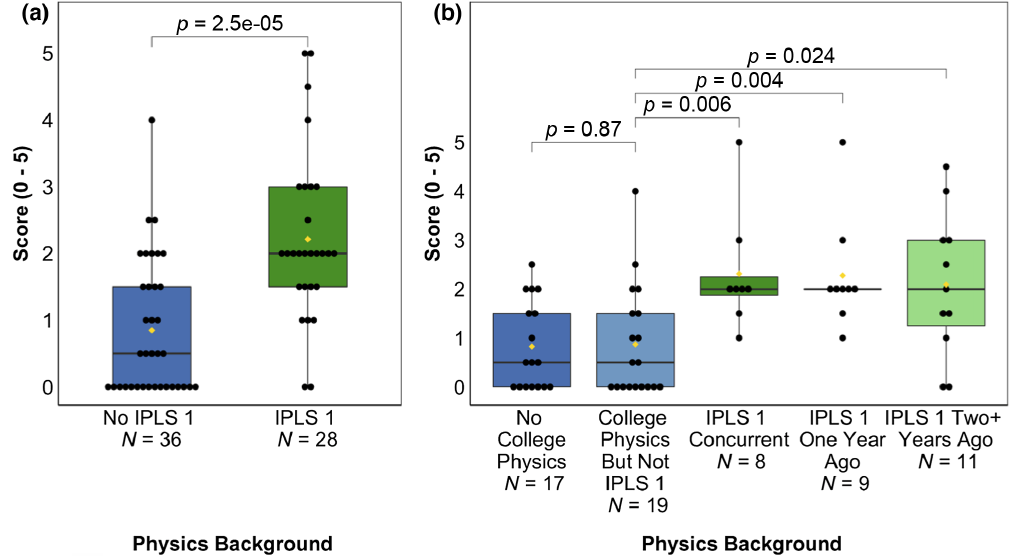
FIG. 2. Scores on the IPLS 1-specific elements of the code. (a) Students who had taken IPLS 1 (green box plot) scored significantly higher on the IPLS 1-specific elements of the code than those who had not taken IPLS (blue box plot). (b) Scores on the IPLS 1-specific elements of the code for those who had taken no college physics, those who had taken non-IPLS 1 college physics, and those who had taken IPLS 1 at different times prior to the capstone course. Taking non-IPLS physics offered minimal if any benefit to students on the IPLS 1-specific tasks (blue box plots), and the significant difference between the IPLS 1 and no-IPLS 1 groups is durable up to at least two years (green box plots). All p values are from Wilcoxon